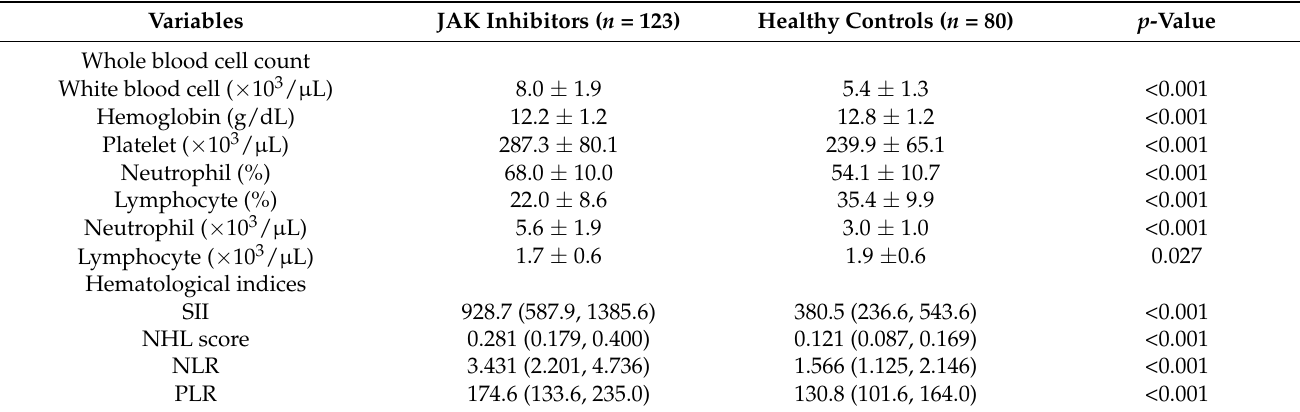
Table 2. Comparison of hematological indices between JAK inhibitors and controls.